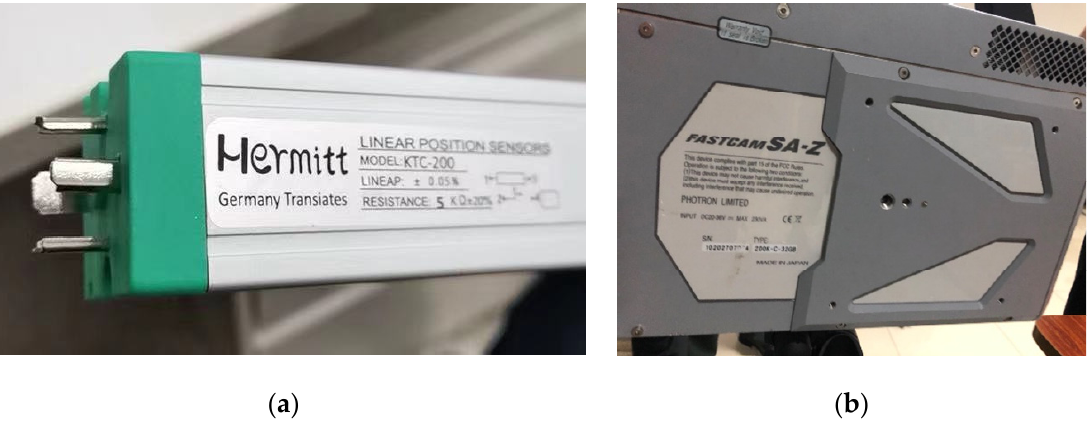
Figure 5. Displacement sensor and high-speed camera. ( a ) Displacement sensor. ( b ) High-speed camera.